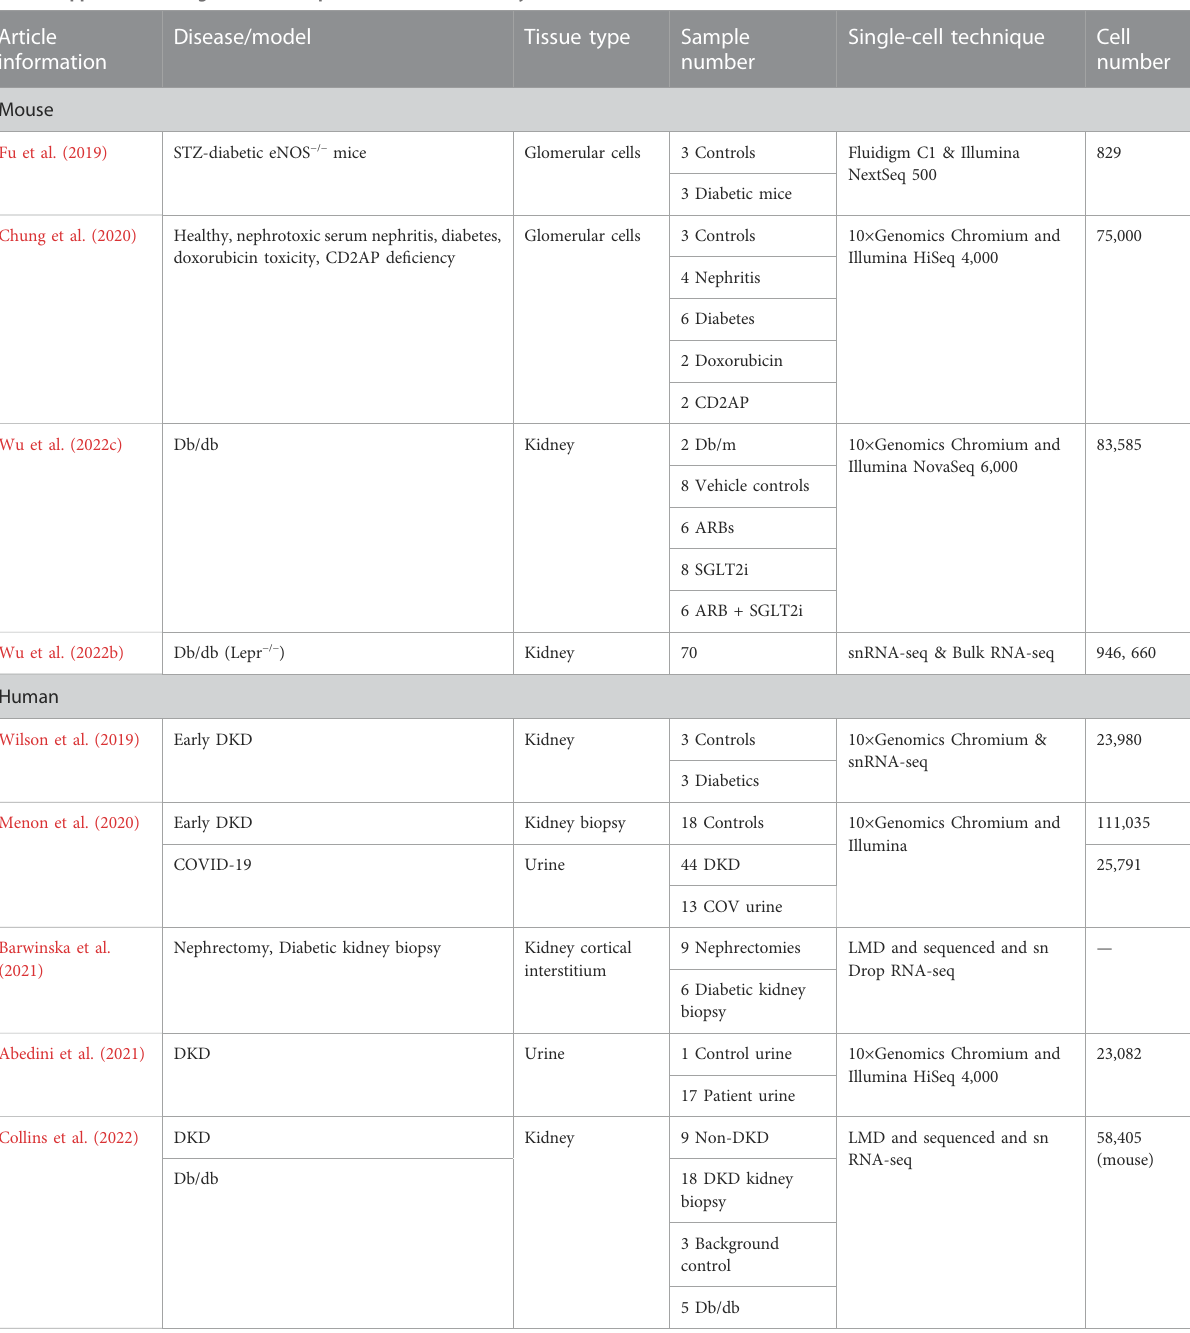
TABLE 3 Application of single-cell transcriptomics in diabetic kidney